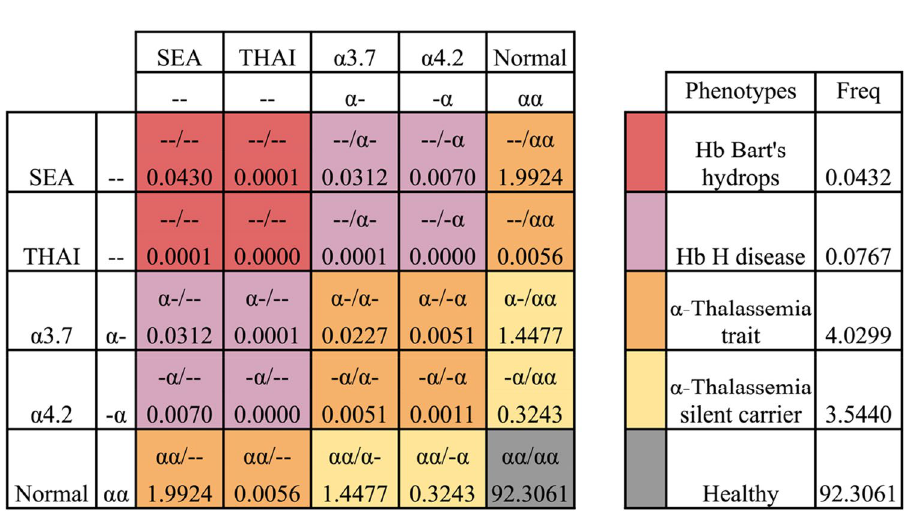
Figure 4. Estimated incidence (%) of α-thalassemia phenotypes in the Vietnamese